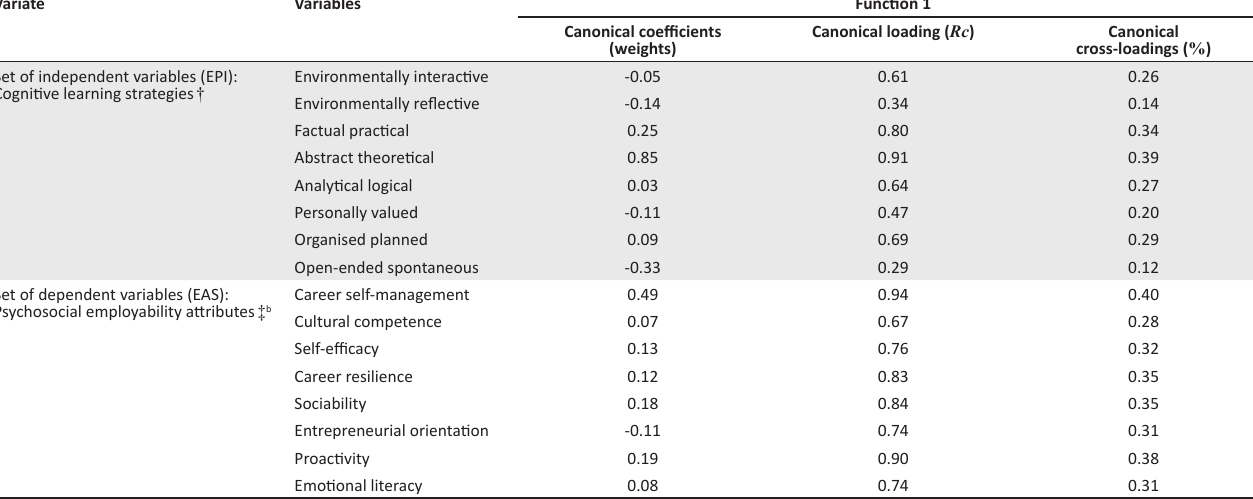
TABLE 2: Standardised canonical correlation analysis results for the first canonical function variates - EPI (independent variables) versus EAS (dependent variables). Variate